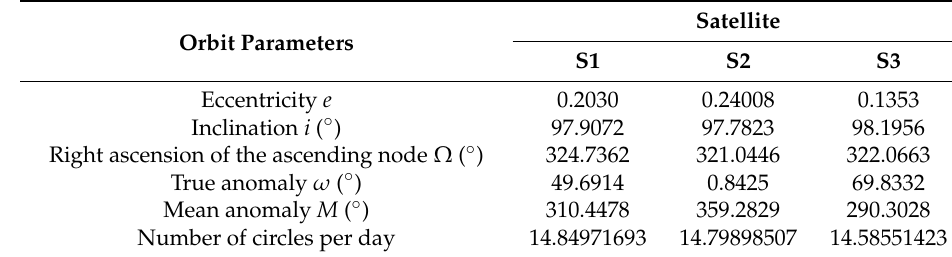
Table 7. Orbit parameters of